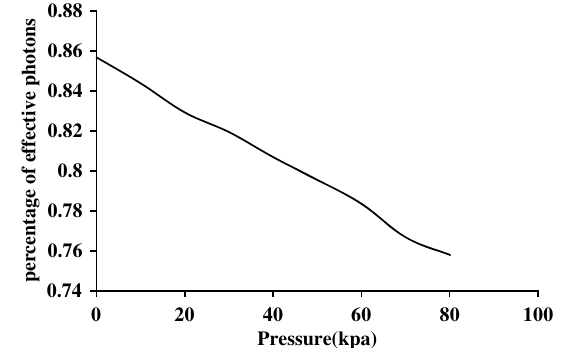
Fig. 9. Variation of e®ective photons with probe